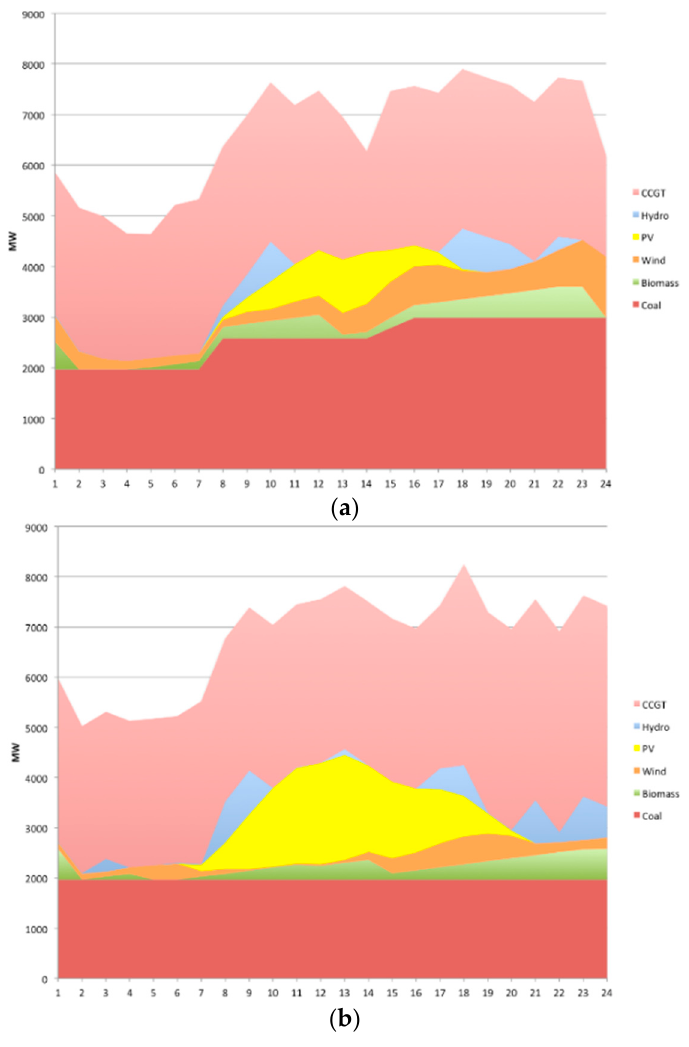
Figure 7. Generation profile—SUD ( a ) winter and ( b ) summer.